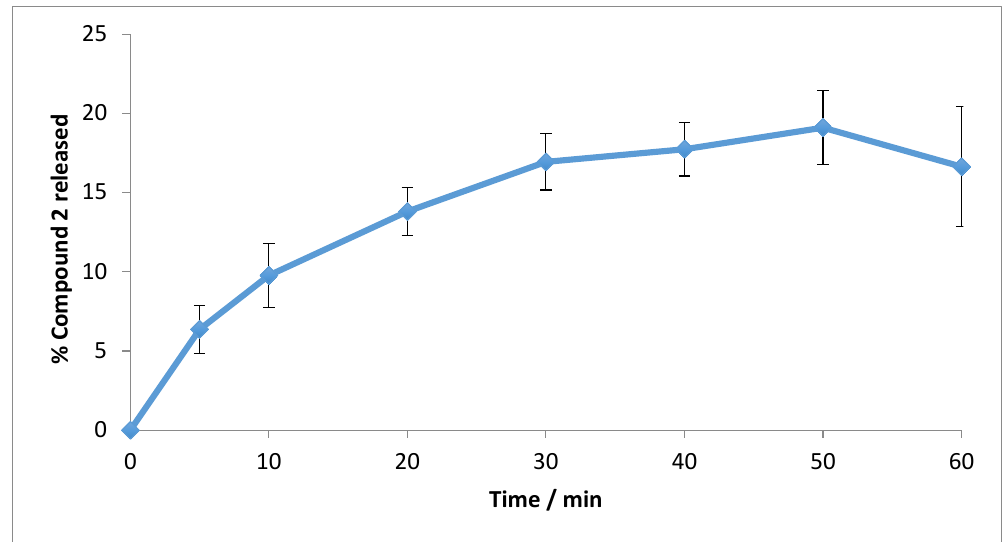
Figure 5. Compound 2 release from the polymer matrix into PBS at 37 °C for 1 h ( n = 3, ±SD).